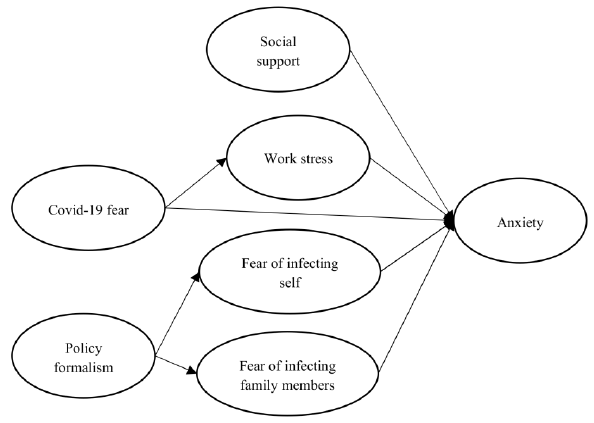
Figure 1. Research Framework.